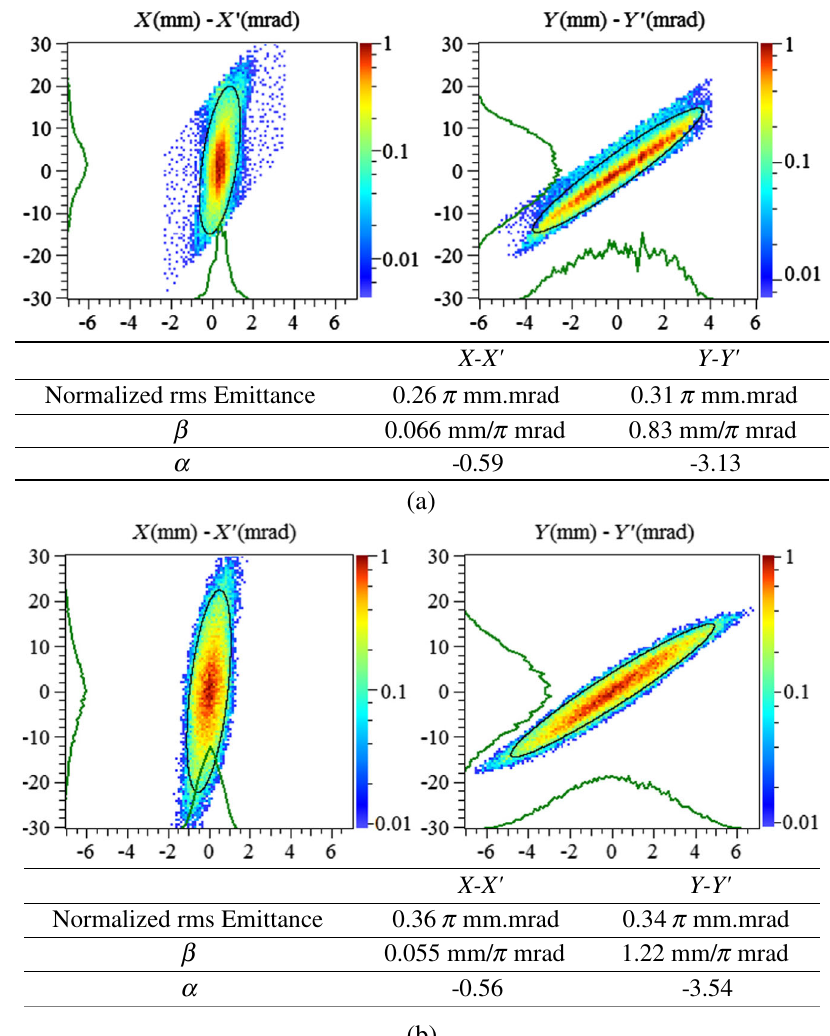
FIG. 12. (a) Measured beam distribution in the horizontal (left) and vertical (right) phase planes at the slit position on the diagnostic bench [3,25]. (b) Expected horizontal (left) and vertical (right) beam phase space from simulation under the nominal beam matching parameters selected by TOPSIS from NSGAII Pareto optimal front for 10 mA RFQ output beam